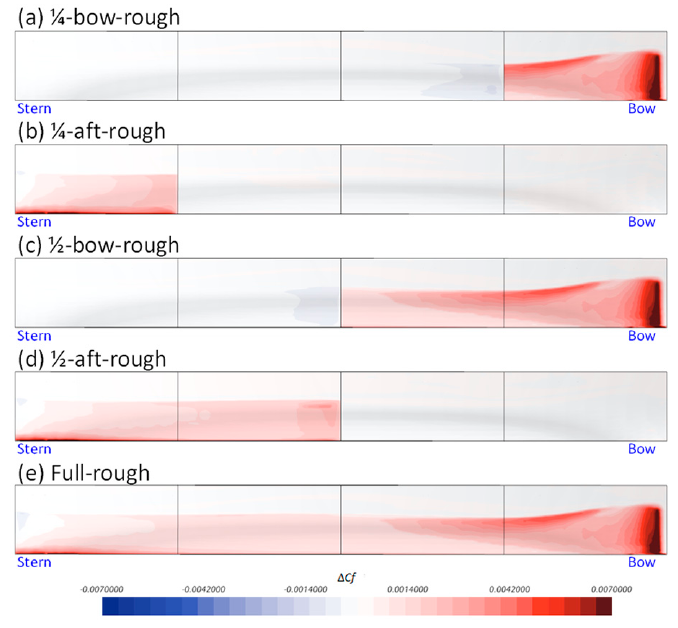
Figure 13. Increase in the C f on the Wigley hull ( ∆ C f = C f , rough − C f , smooth ), Fr = 0.3. Figure 14 shows the distributions of the roughness Reynolds number, k + , on the Wigley hull with different hull roughness conditions. As expected, the full-rough case shows larger k + values in the bow region due to higher local skin friction (i.e., k + = k τ w / ν ). For a similar reason, the bow-rough cases show larger k + values compared to the aft-rough cases, and these differences result in different ∆ C f values. This observation supports the hypothesis of Song et al. [27].